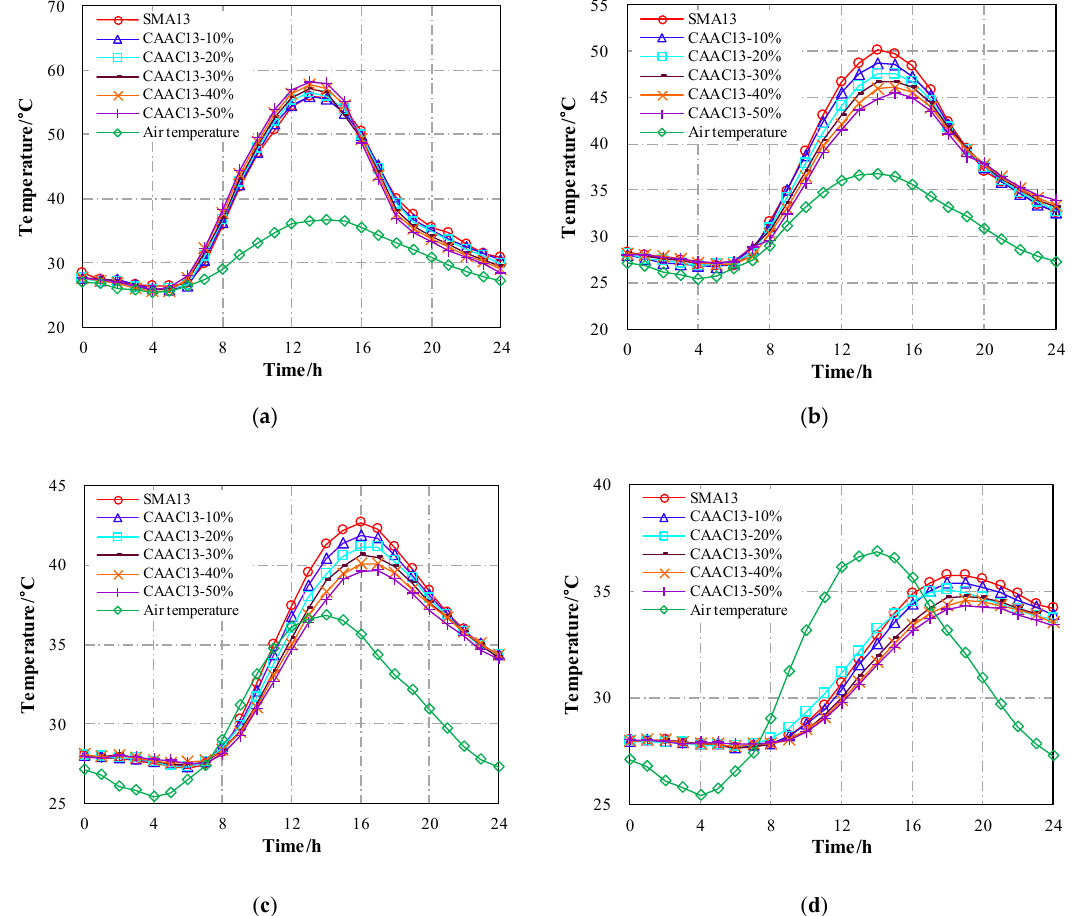
Figure 11. Effect of CASMA-13 on the temperature evolution of asphalt layers: ( a ) Road surface; ( b ) 4 cm depth; ( c ) 10 cm depth; ( d ) 18 cm depth.